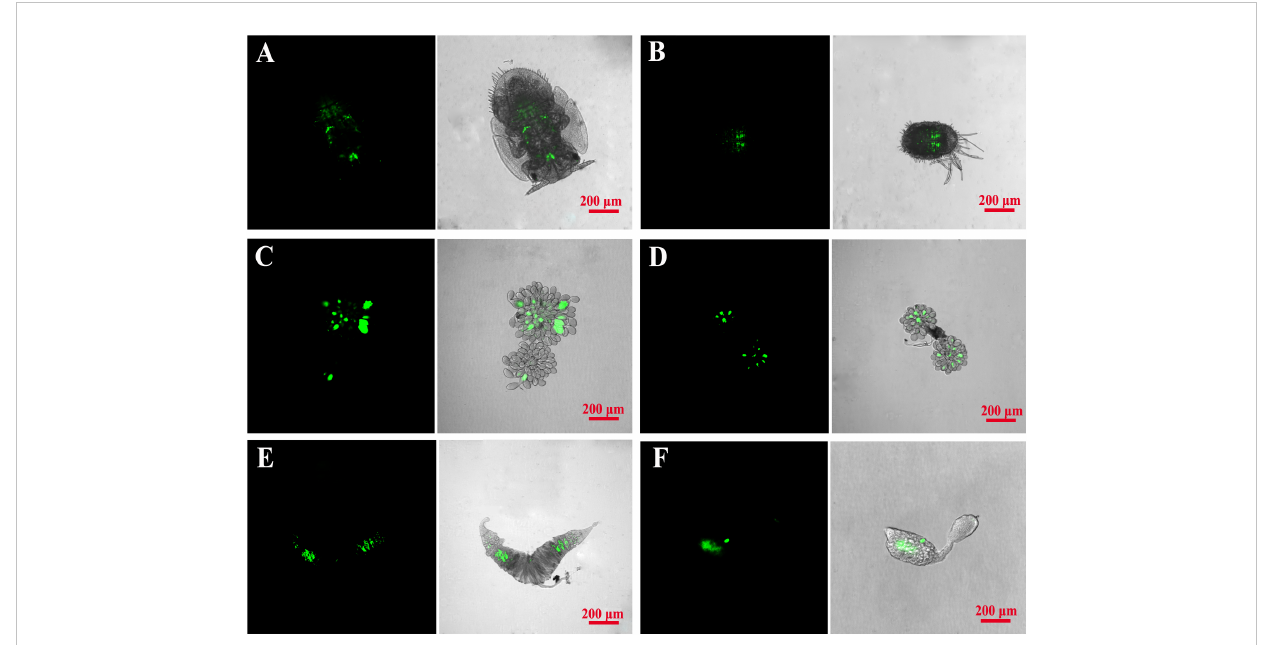
FIGURE 7 Fluorescence in situ hybridization visualization of Wolbachia in Asian citrus psyllid and longan psyllid. Wolbachia was respectively stained green by speci fi c probes. (A, B) : D. citri and C. sinica 4 th nymphal stage; (C, D) : D. citri and C. sinica ovary; (E, F) : D. citri and C. sinica